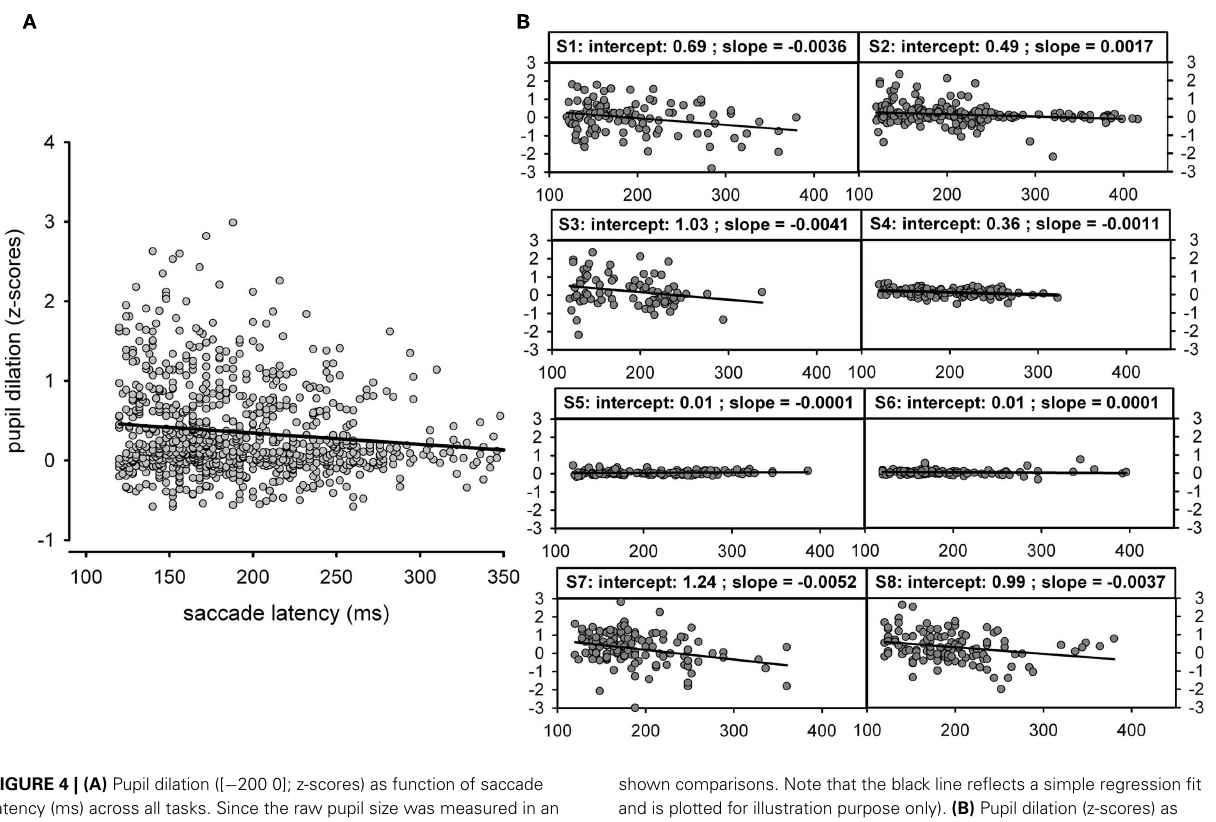
shown comparisons. Note that the black line reflects a simple regression fit and is plotted for illustration purpose only). (B) Pupil dilation (z-scores) as function of saccade latency (ms) across all tasks but plotted separately for each participant.